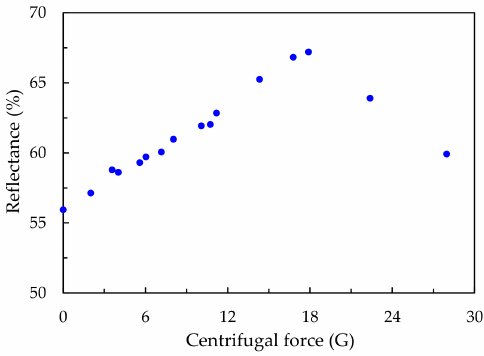
Figure 5. Reflectance values of samples stacked with a 50 wt % silica colloidal solution under different centrifugal forces.